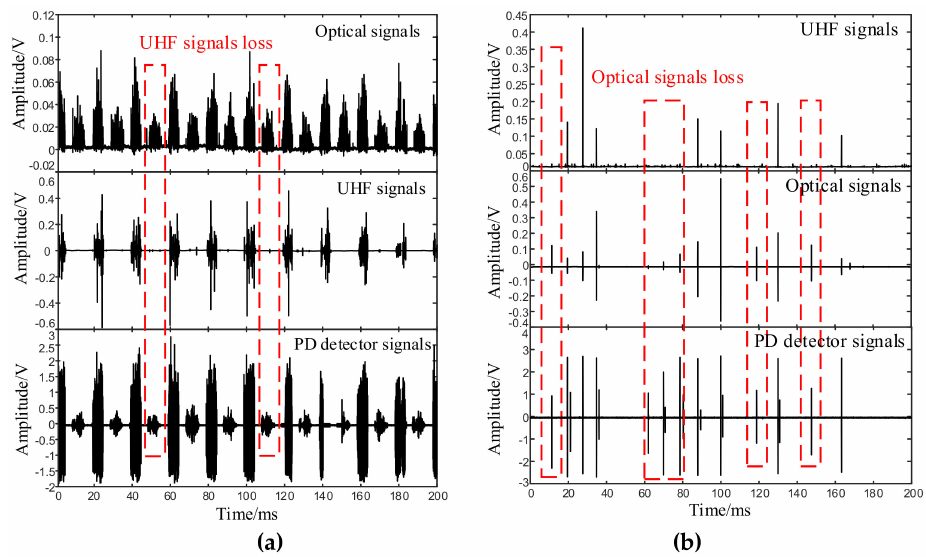
Figure 3. Optical and ultrahigh frequency (UHF) PD signals with di ff erent defects. ( a ) Time domain waveform of needle defect and ( b ) time domain waveform of free particle